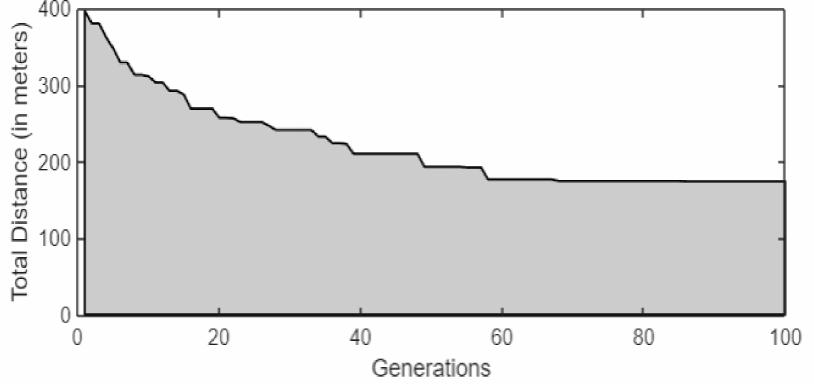
Figure 13. Distance versus generation graph.